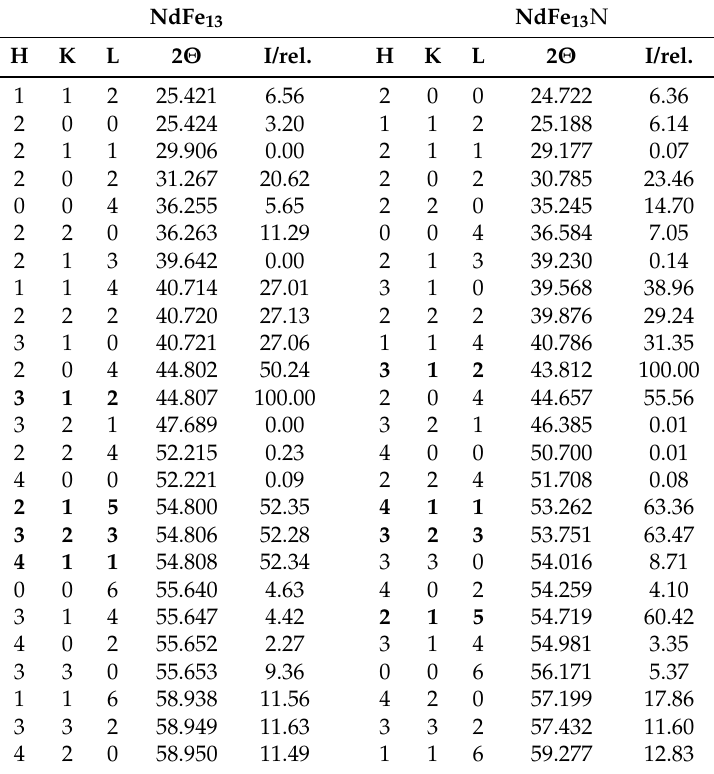
Table A1. Diffraction-peak positions and intensities for the crystal structures of NdFe 13 and NdFe 13 N calculated with the software PowderCell (version 2.4) [40] for a cobalt cathode. As X-ray source a Co cathode was assumed ( K α 1 = 1.789007 nm). Only the range for 2 Θ from 25 to 60 degrees is listed. The intensities are given in % relative to the strongest peak 312. This peak and the three peaks 215, 323, and 411, which are addressed in Section 3.1, are marked by bold